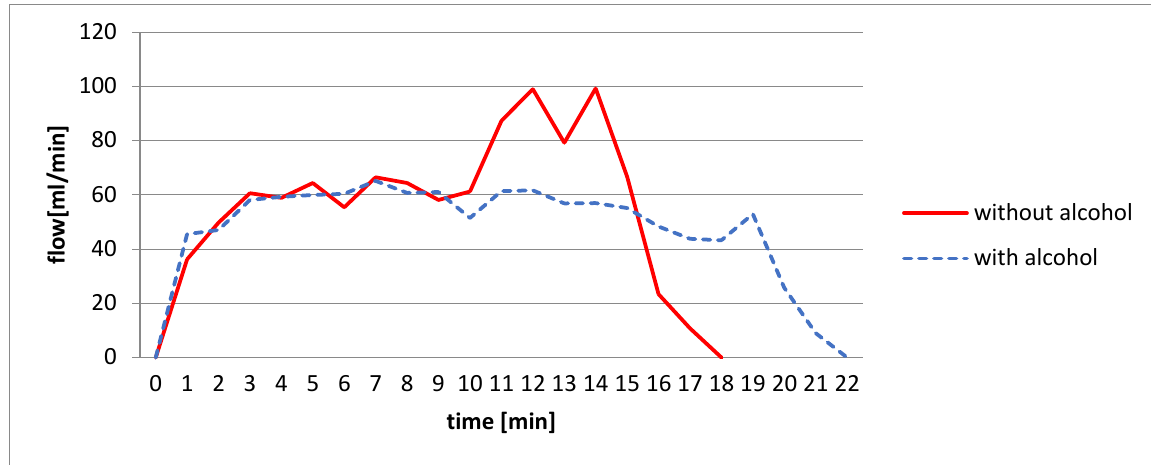
Figure 5. Hydrogen flow generated comparison Q (H 2 , t) from a 7.5 M sheet, with and without isopropyl alcohol at initially 60 °C.